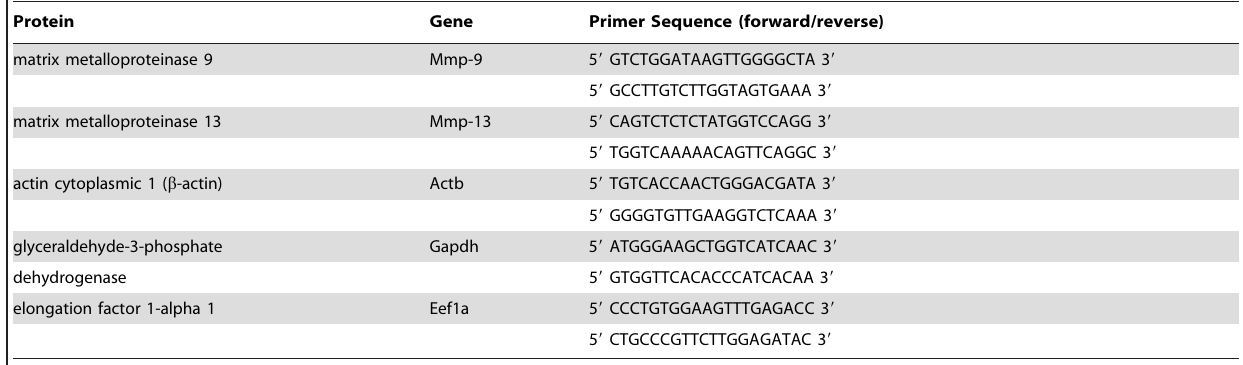
Table 1. Primer sequences.